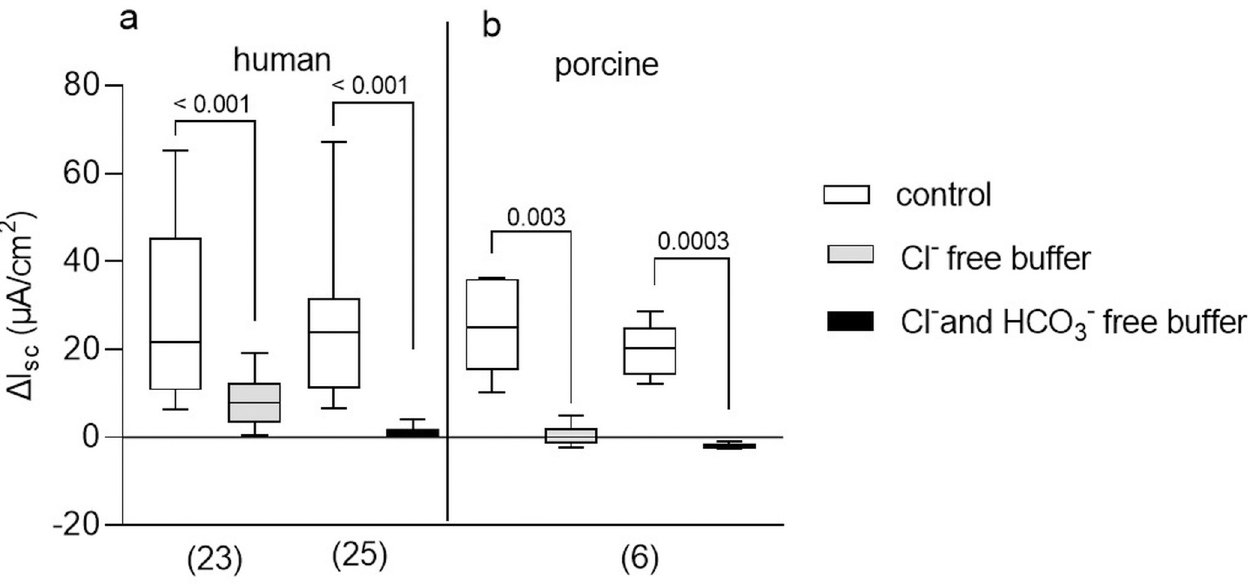
Fig 5. Ionic basis of the distension induced secretory response. Distension induced secretory responses in human (a) and porcine (b) colonic tissue evoked by P ser was significantly reduced by depletion of chloride (Cl - ) and Cl - and bicarbonate (HCO 3- ), respectively (human: Wilcoxon test; porcine: Paired t test; p values above brackets). Data shown are the medians with the 25 th and 75 th quartiles as a box plot and the minima and maxima as a whisker plot. N numbers are given in